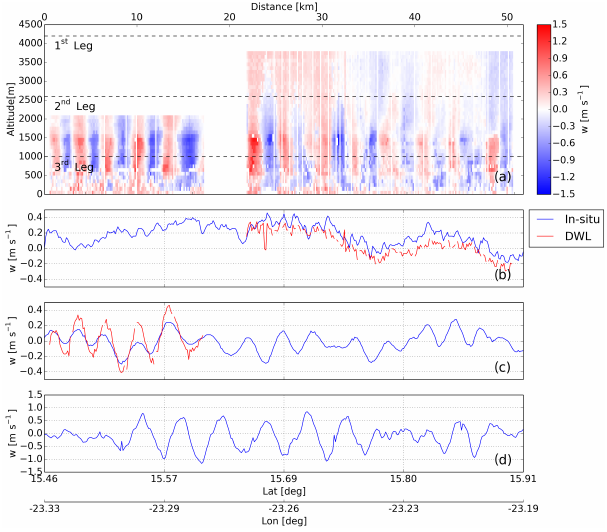
Figure 7. (a) Retrieved vertical wind speed by the DWL as a func- tion of the latitude and longitude from legs 1 (10:21 to 10:25LT) and 2 (10:43 to 10:46LT), together with the flight levels correspond- ing to the legs 1, 2 and 3 (11:10 to 11:16LT) (dashed lines). (b, c, d) In situ vertical wind speed corresponding to the legs 1, 2 and 3 (blue line) together with the measured wind corresponding to the uppermost range gate measured on each leg (red